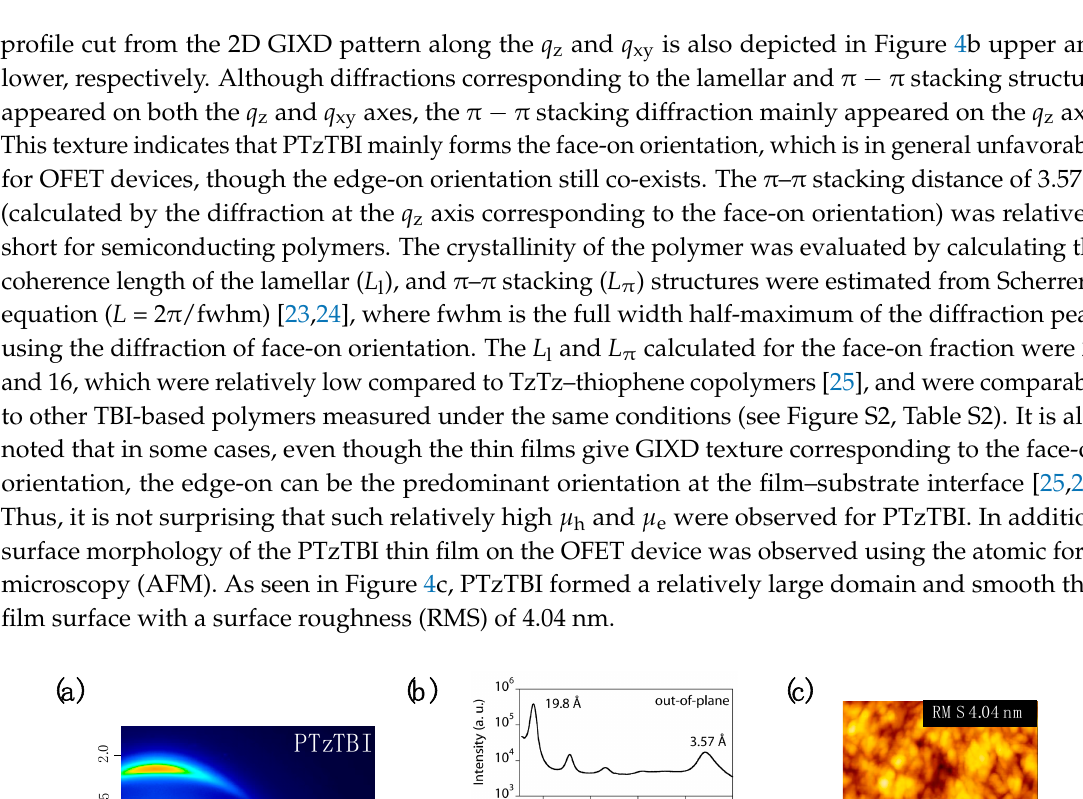
Figure S1. 1 H-NMR spectra of PTzTBI. Figure S2. X-ray diffraction patterns of TBI-based polymers. Table S1. Detailed X-ray diffraction parameters of TBI-based